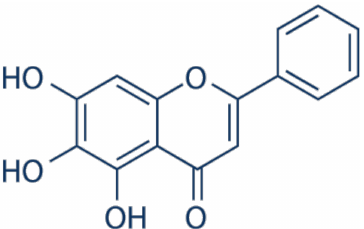
Figure 2. The chemical structure of